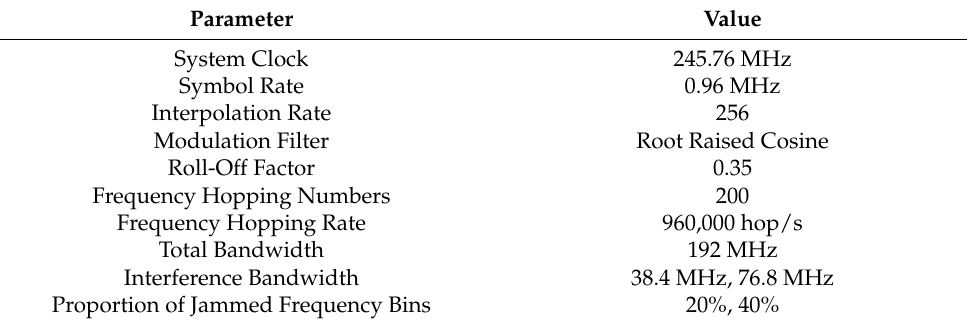
Table 3. Core FH system simulation parameters.